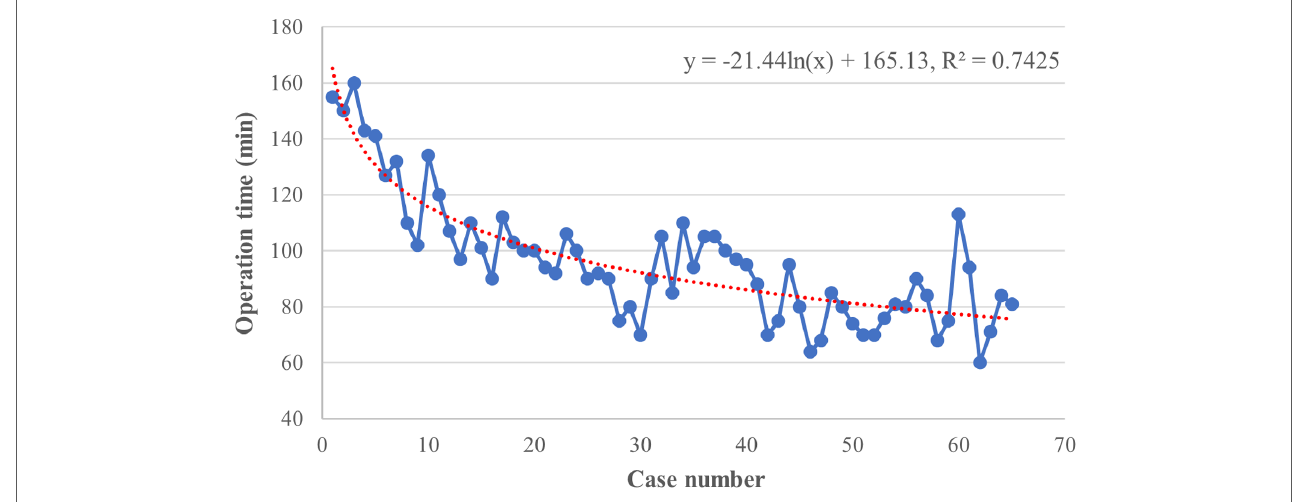
FIGURE 2 Graph of the raw operative time (OT) plotted against chronological case numbers (65 consecutive patients). The red dashed line represented the curve of best fi t for the plot [ y = − 21.44 ln( x )+165.13, R 2